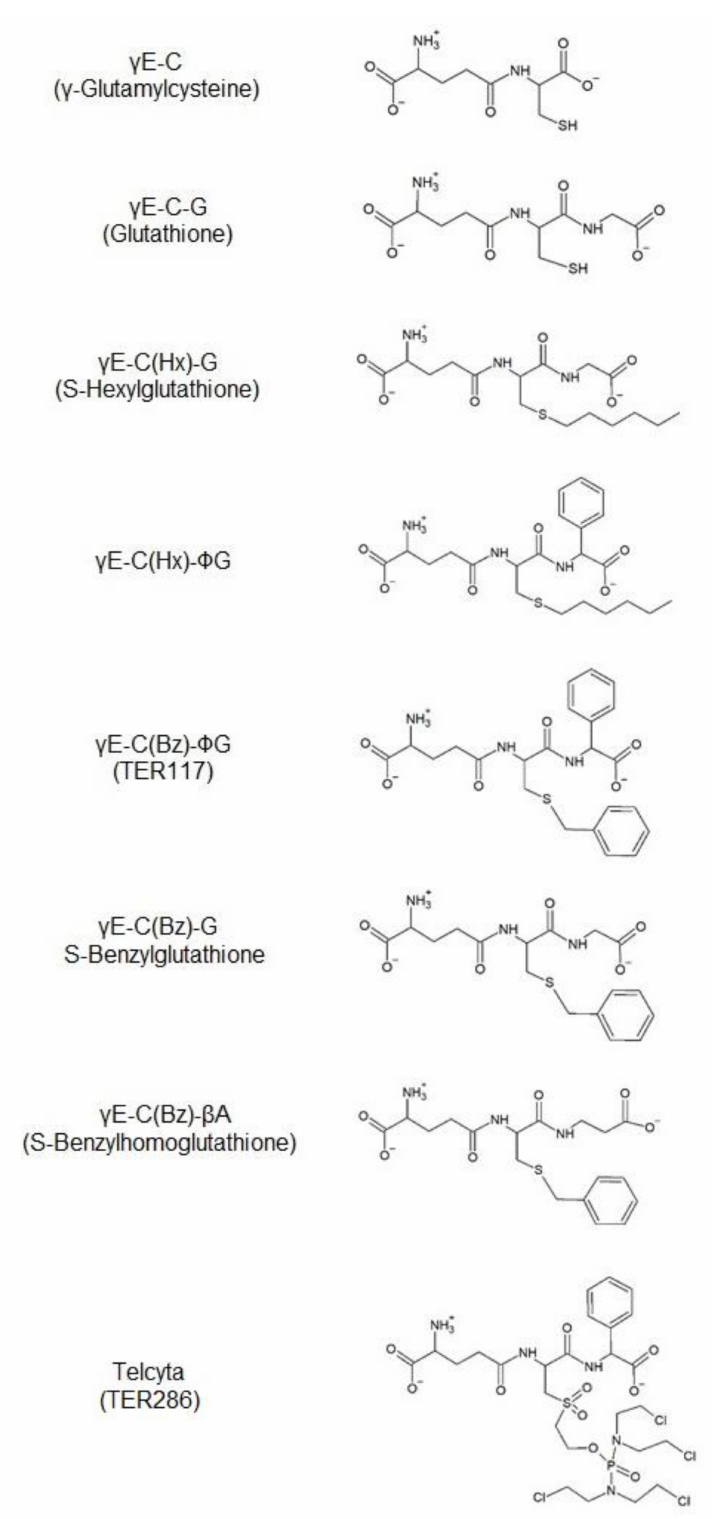
Figure 1. The two alternative thiol substrates and the competitive inhibitors used in the study. L-cysteinyl-R(-)-phenylglycine) and TER286 ( γ -glutamyl- α -amino- β -(2-ethyl-N,N,N (2-chloroethyl)phosphorodiamidate)sulfonylpropionyl-R(-)phenylglycine were of